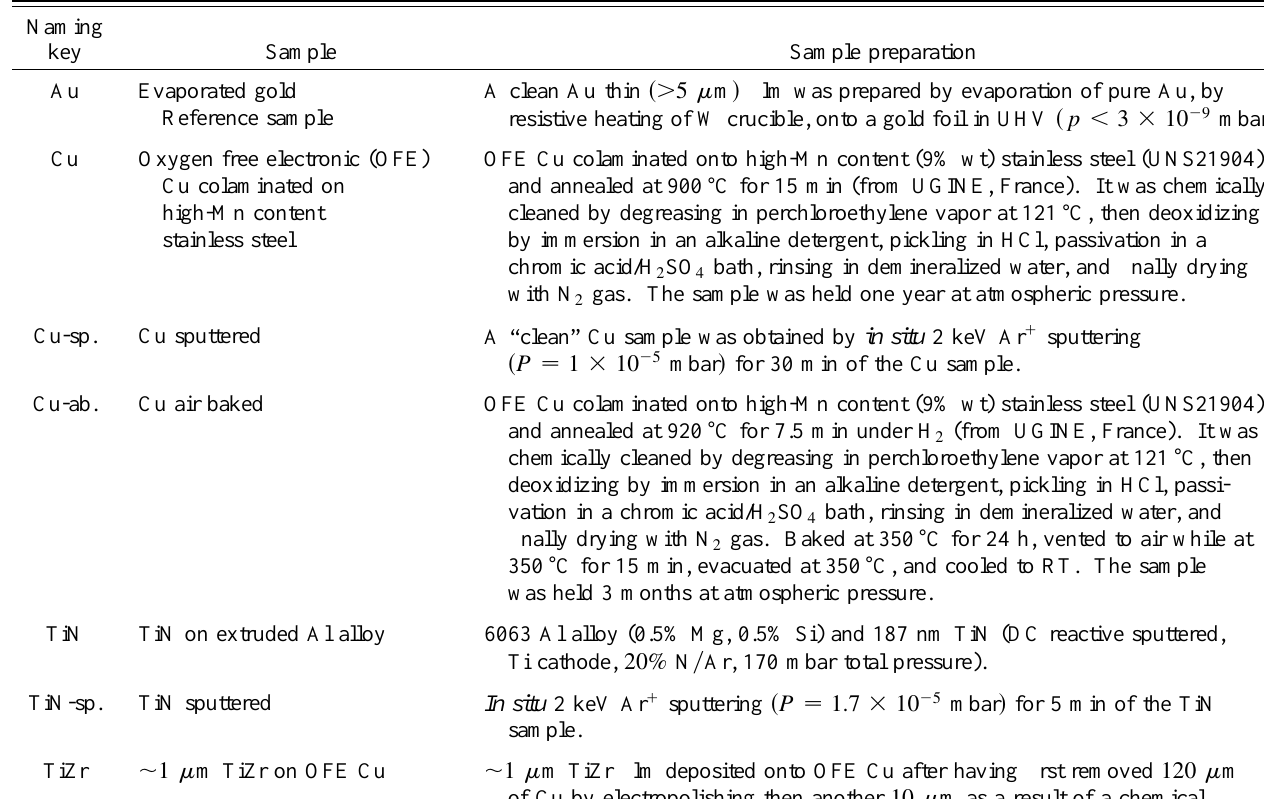
TABLE II. The sample and sample preparation details. The naming key will be used throughout the rest of the paper to refer to each sample studied.